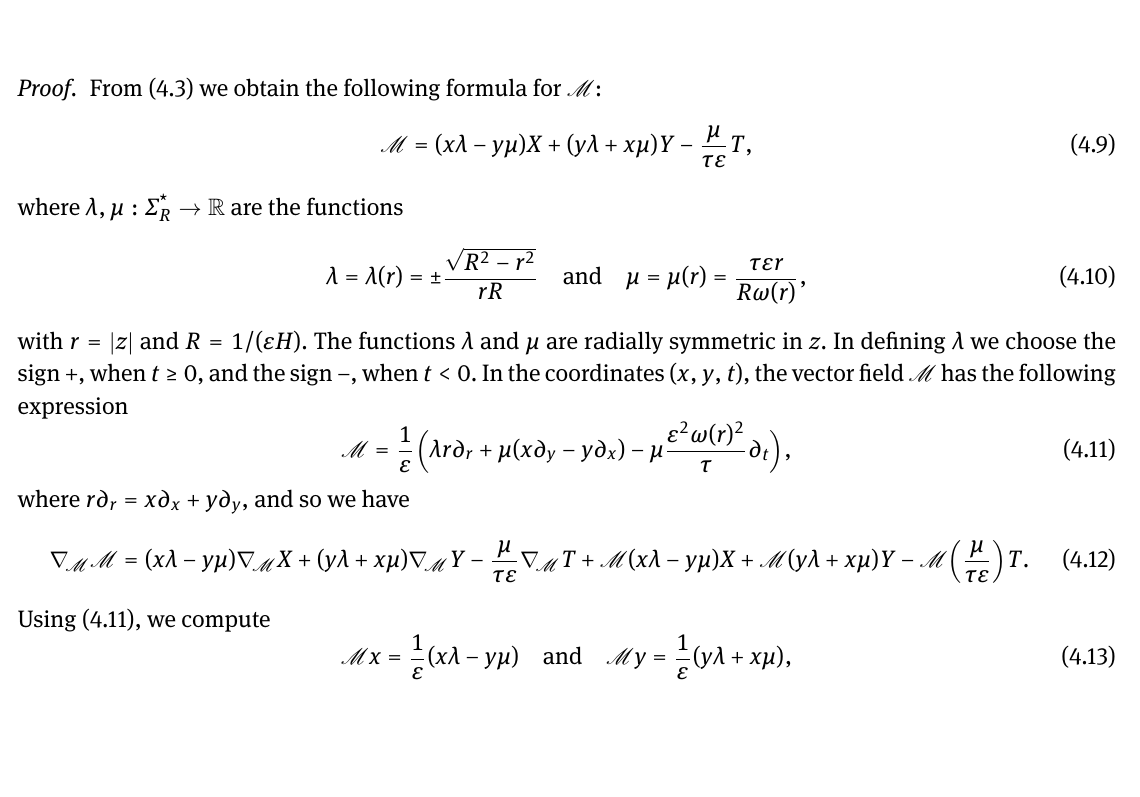
Figure 1: The plotted curve is an integral curve of the vector field M for R = 2 , ε = 0.5 , and σ = 0.5